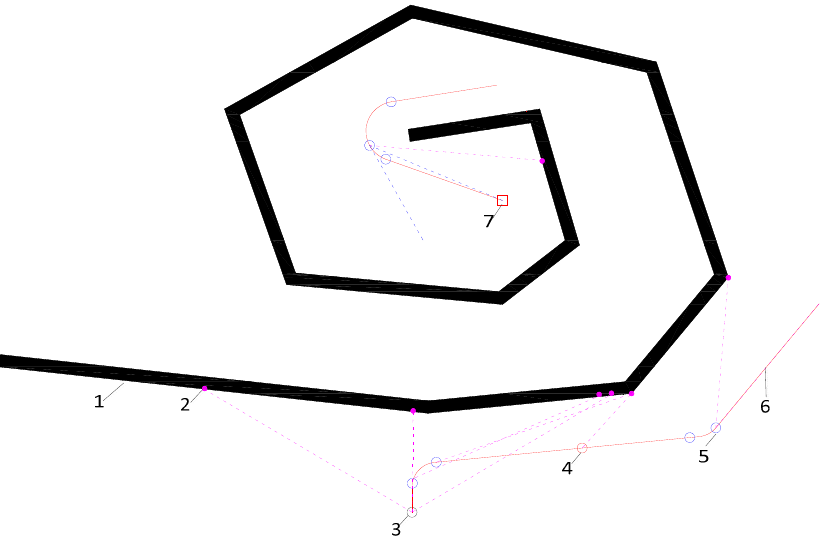
Figure 9. Wall-form obstacle avoidance. 1-wall form obstacle; 2-recorded obstacle point; 3-start record position; 4-supplement record position; 5-transition position; 6-obstacle trajectory; 7-target. These obstacle points are kept in a storage array , As a demonstration in Figure 9, when the wall-form obstacles are identified and it is decided to detour around their right side, the first three obstacle points are recorded in array D in order, which are the leftmost point S 0 , dead ahead point S 39 and rightmost point S 79 . Then the next obstacle point position is added into array D as mentioned above. This is repeated until this obstacle is passed by, and the simulation process is explained in the following section.